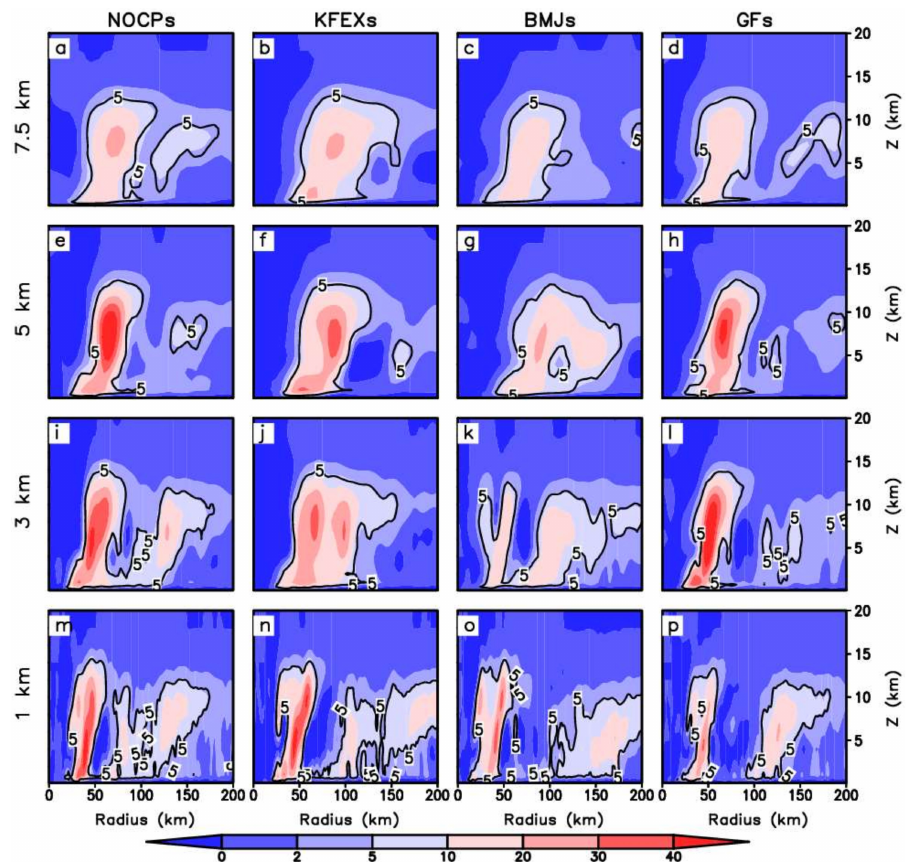
Figure 5. Azimuthal- and time-averaged cross-sections of the model-simulated diabatic heating ( ◦ C h − 1 ; shaded) and the solid line represents the 5 ◦ C h − 1 contour line of simulated diabatic heating in the TC mature stage. The model resolution is 7.5 km ( a – d ), 5 km ( e – h ), 3 km ( i – l ) and 1 km ( m – p )